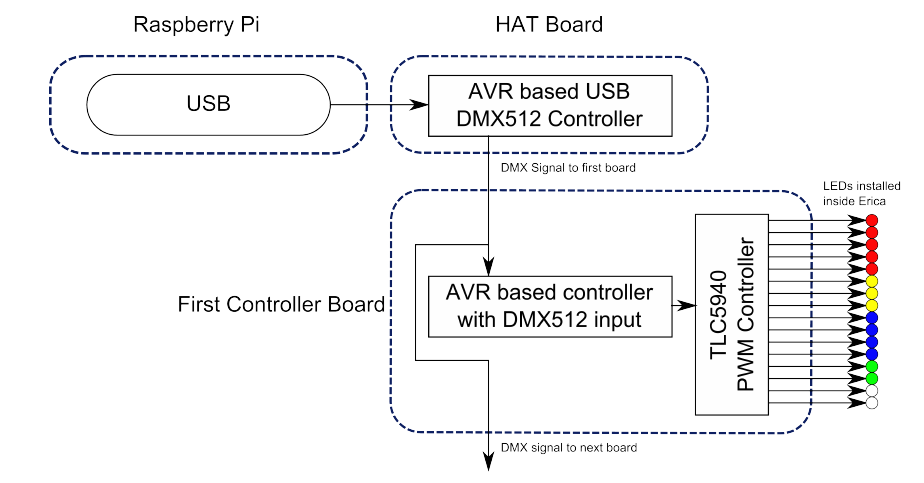
Figure 10. New DMX based design for Erica’s LED controllers.